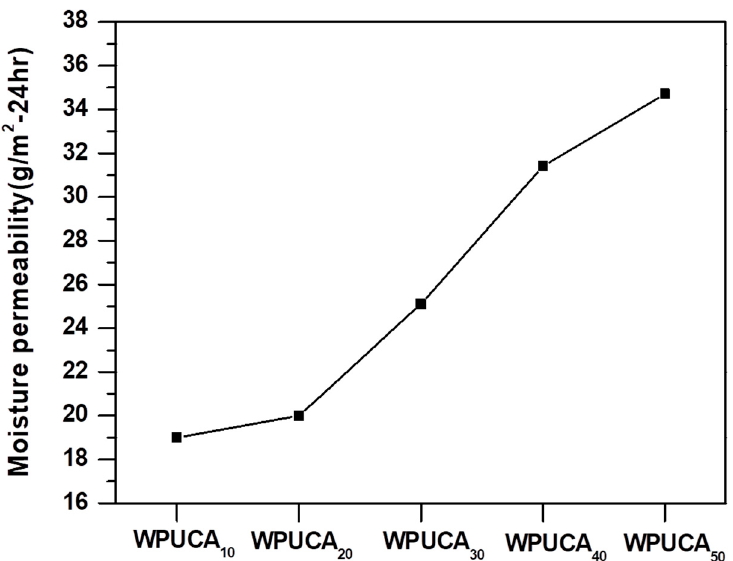
Figure 3. Moisture permeability of the blends with different WPU/CA weight ratios.